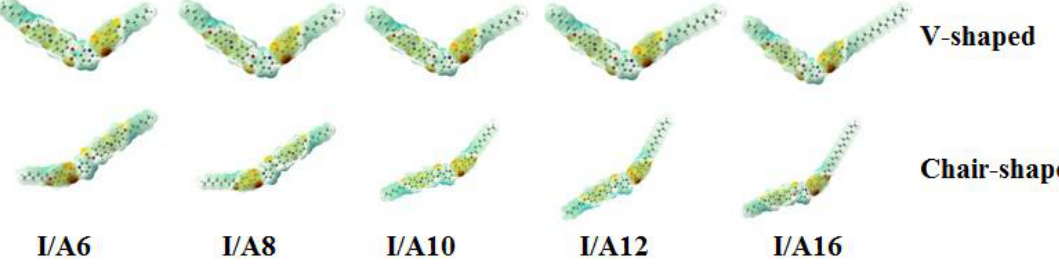
Figure 10. Molecular electrostatic potentials (MEP) for SMHBCs of both isomers of the nicotinate base, I/An .